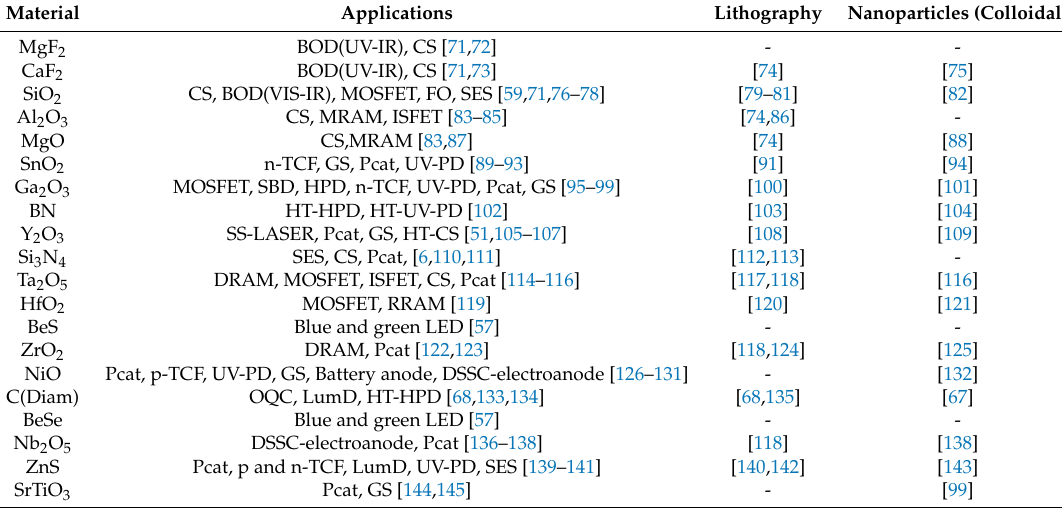
Table 1. Summary of materials, their primary applications or potential applications and reported nanostructures based on those